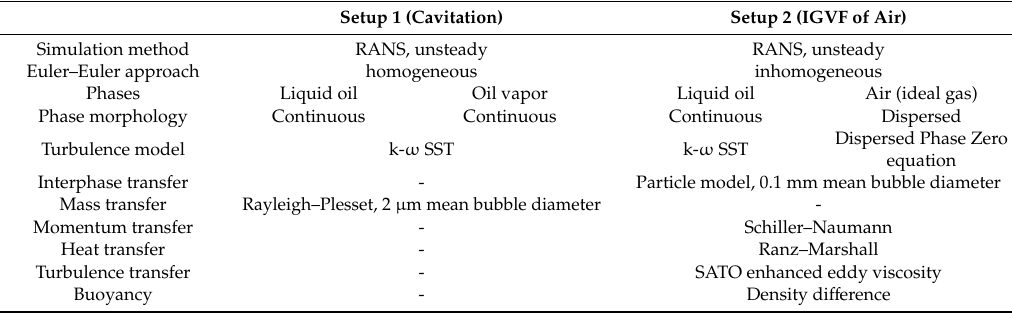
Table 1. Overview of setups for multiphase flow simulations.